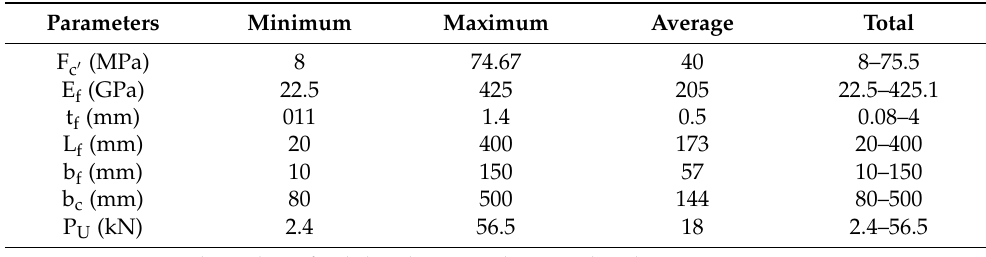
Table 1. Bond strength test database.